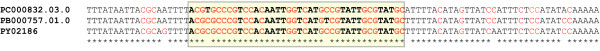
A 40 bp region upstream of the P. yoelii gene PY02186 conserved beyond the neutral background. The region is shown with corresponding orthologous sequences of P. chabaudi, P. berghei. The conservation pattern of the highlighted block – in addition to 609 other blocks in the P. yoelii genome – has a less than 10-6 probability of occurring by chance, based on silent site substitution patterns. While the unhighlighted sections are mostly conserved as well, the highlighted region stands out for its high density of conserved G's and C's, which are rare (6.3%) in 4-fold degenerate positions.